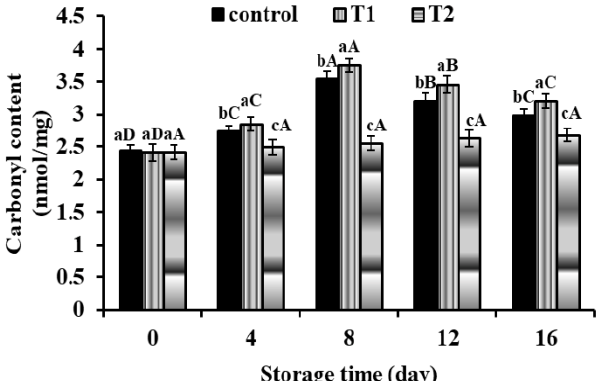
Figure 5. Changes in carbonyl content (nanomoles of carbonyl/milligram of protein) in meatball samples with incorporated cod liver oil microcapsules during storage at 4 ± 1 °C. Error bars represent standard deviation (n = 3). T1: free cod liver oil direct addition, T2: encapsulated cod liver oil. Different superscripts of (a–c) lowercase letters indicate significant differences at p < 0.05 between treatments at each storage time. Different superscripts of (A, B) uppercase letters indicate significant differences at p < 0.05 of each sample over the storage period.